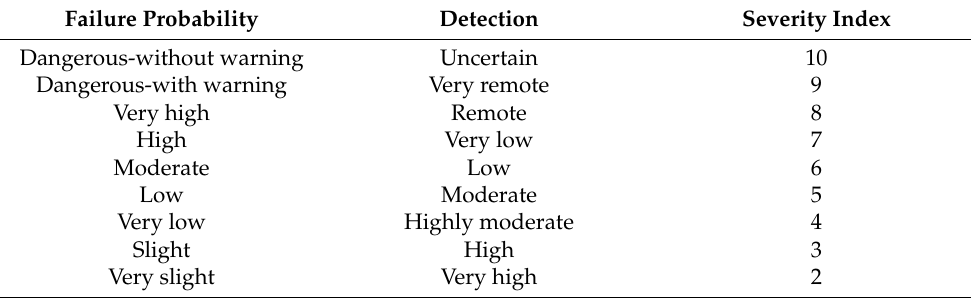
Table 8. Weight of criteria related to identifying the most critical failure